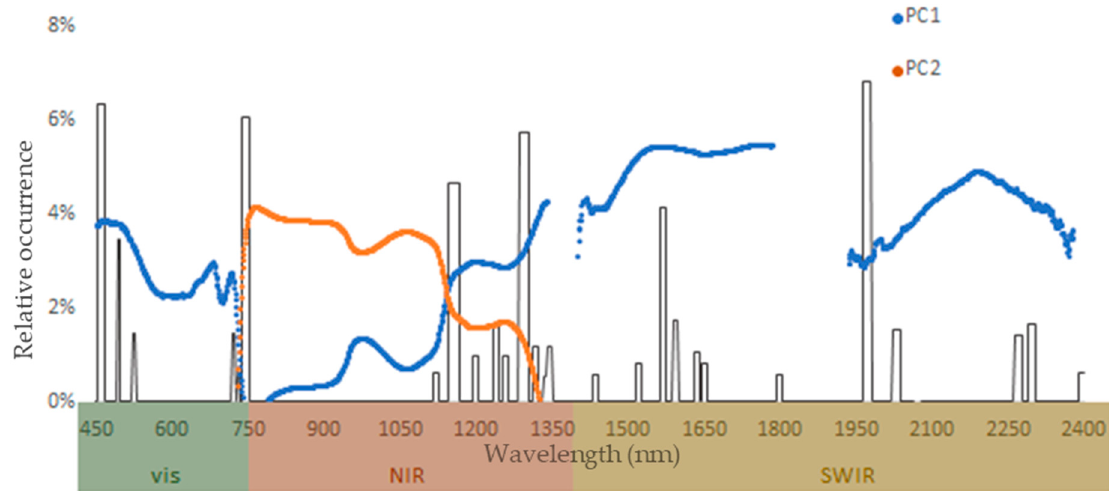
Figure 6. Weighted wavelength occurrence on nitrate content ([Nitrate]) estimation. Black line: occurrence frequency, in best-performing Vegetation Indexes (VIs), listed in Table 7, weighted by produced R2 (coefficient of determination) in the [Nitrate] estimation (ordinate axis), of wavelength bands (abscissa axis express as nm)—width calculated concerning instrumental spectrum resolution (see Section 2.2). For clarity, in the same graph, PC1 and PC2 highest loading values (threshold above 0.5) are represented in blue and red,